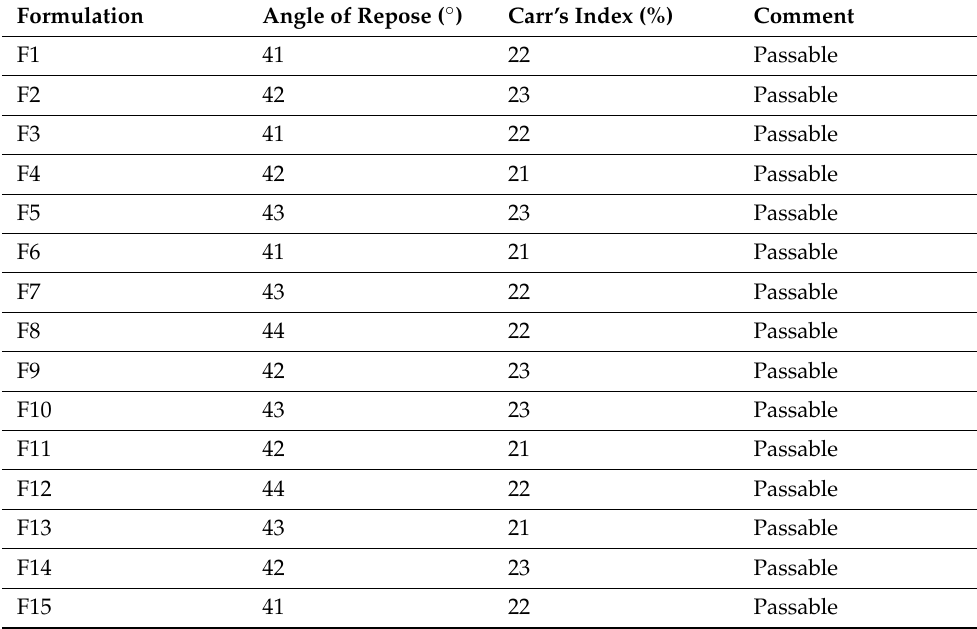
Table 1. Flow characteristics of LX DT powder blends .